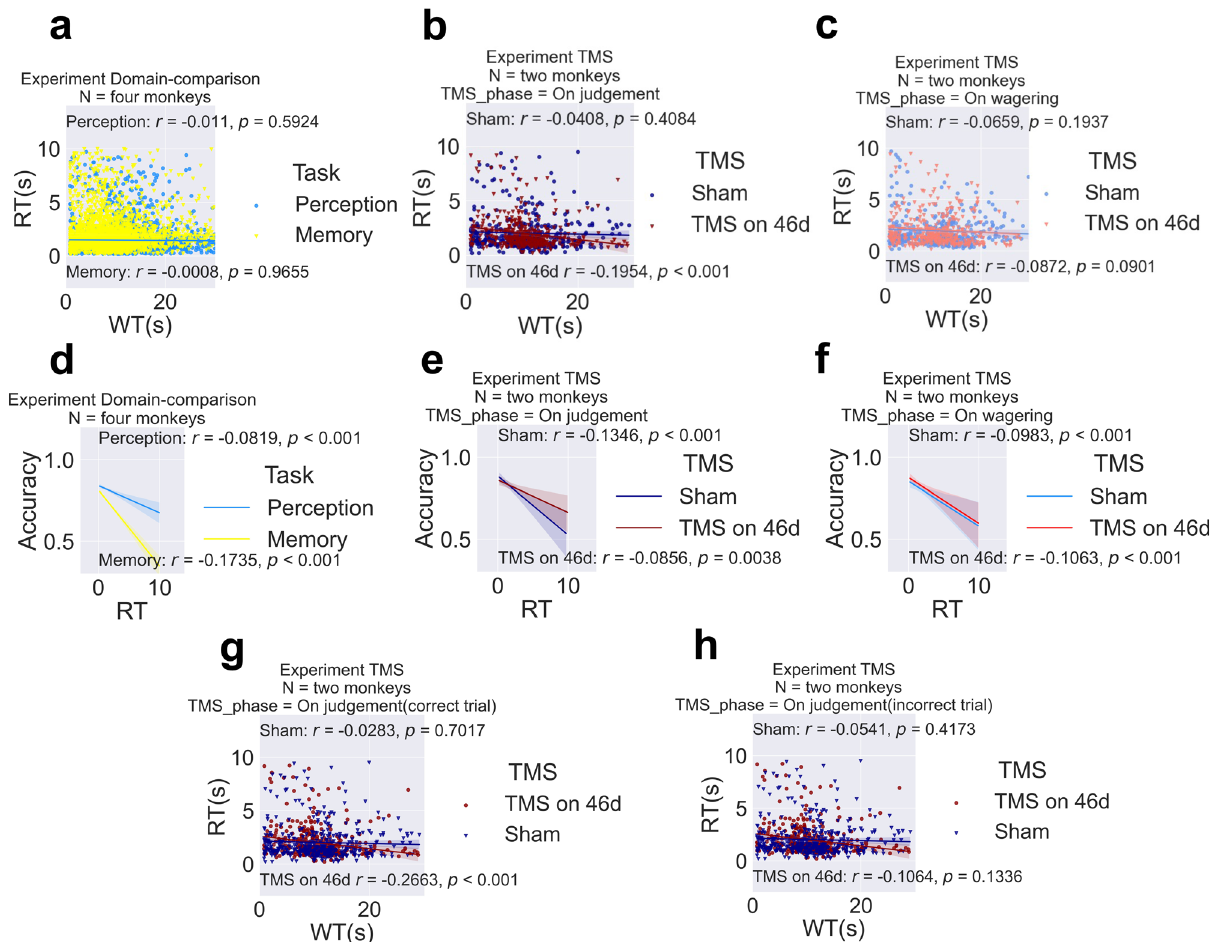
Fig. 3 On-judgement TMS alters the correlation between reaction time (RT) and wagered time (WT). No correlation was found between RT and WT in the domain-comparison experiment ( a ). The Pearson correlation between RT and WT during the on-judgement phase was statistically signi fi cant for the TMS-46d condition ( p < 0.001) but not signi fi cant for the TMS-sham condition ( b ). The correlations during the on-wagering phase were not signi fi cant for either TMS condition ( c ). RT was signi fi cantly negatively correlated with accuracy (correct/incorrect) in the domain-comparison experiment ( d ) and in both TMS phases in the TMS experiment ( e , f ). A negative correlation between RT and WT in TMS-46d condition in correct trials ( g ) but not in incorrect trials ( h ). Shaded areas indicate bootstrap-estimated 95% con fi dence intervals for the regression